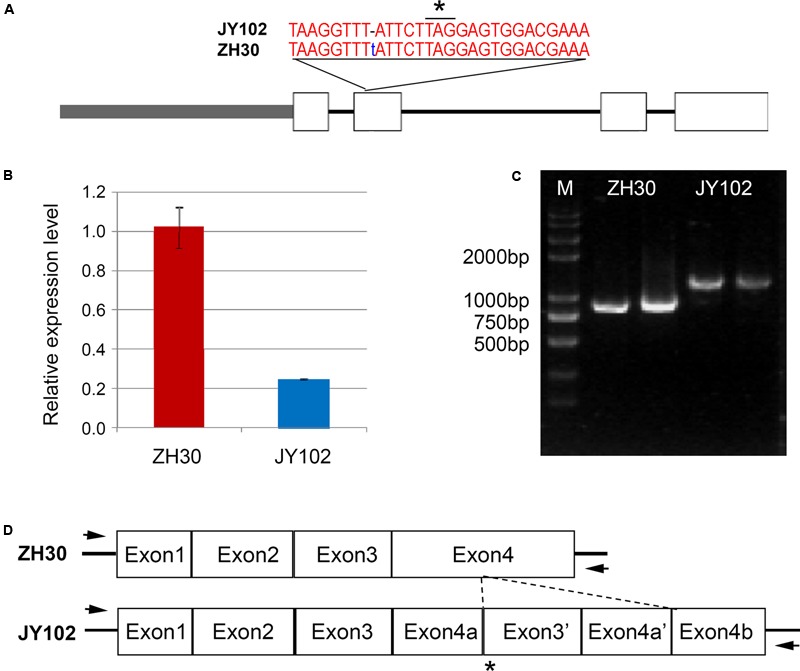
Sequencing confirmation of candidate genes of qCC1 and qCC2. (A) Variation of Glyma.01g214600 in ZH30 and JY102. JY102 has a single-base deletion in the second exon, resulting in a frameshift and premature termination of translation. Star indicated the stop codon. (B) Expression of Glyma.01g214600 in ZH30 and JY102 plants. (C) Amplified fragments of Glyma.11g027400 from ZH30 and JY102. (D) Gene structure of Glyma.11g027400 in ZH30 and JY102. JY102-type Glyma.11g027400 contains a duplicated copy of exon 3 and exon 4. Star indicated the stop codon and arrows indicated the locations of primers.